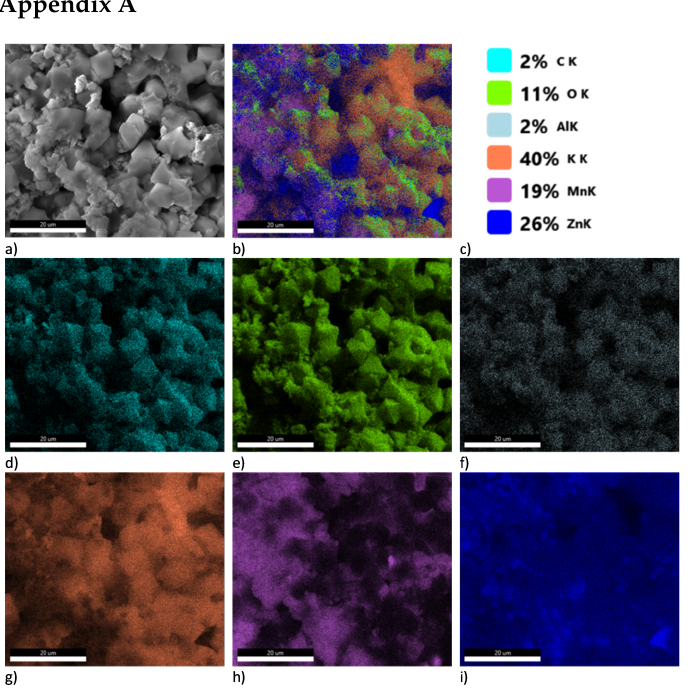
Figure A1. Result of SEM-EDS analysis for sample Zn1. ( a )—SEM picture; ( b )—EDS map; ( c )— weight concentration %; ( d )—EDS map for C; ( e )—EDS map for O; ( f )—EDS map for Al; ( g )—EDS map for K; ( h )—EDS map for Mn; ( i )—EDS map for Zn.